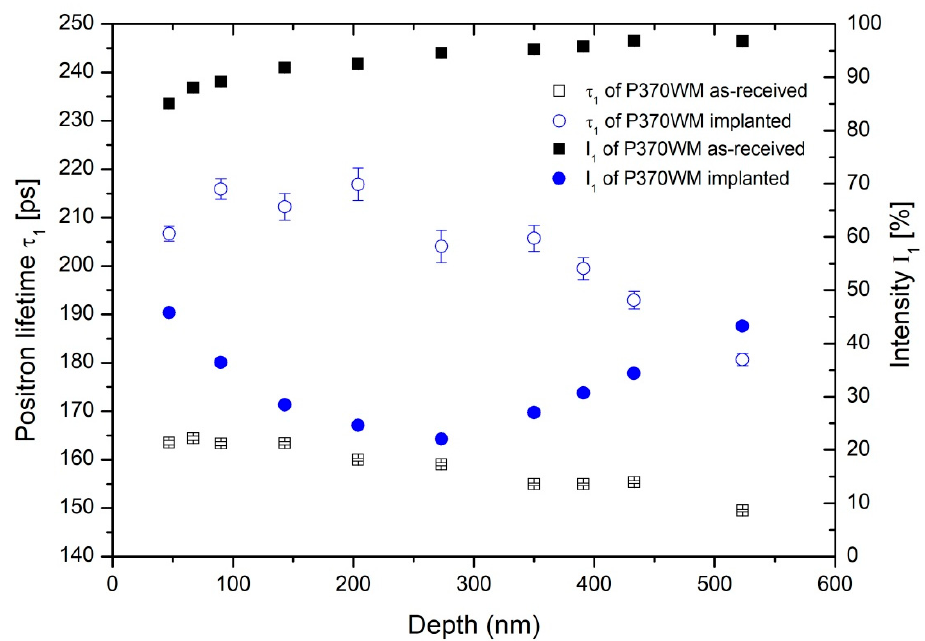
Figure 3. Comparison of PLEPS parameters in two components analyze of specimen P370 WM, before and after H + implantation by 100 keV (maximal damage at about 12 keV corresponding to depth of about 400–450 nm). Lifetimes and intensities of first component are presented.